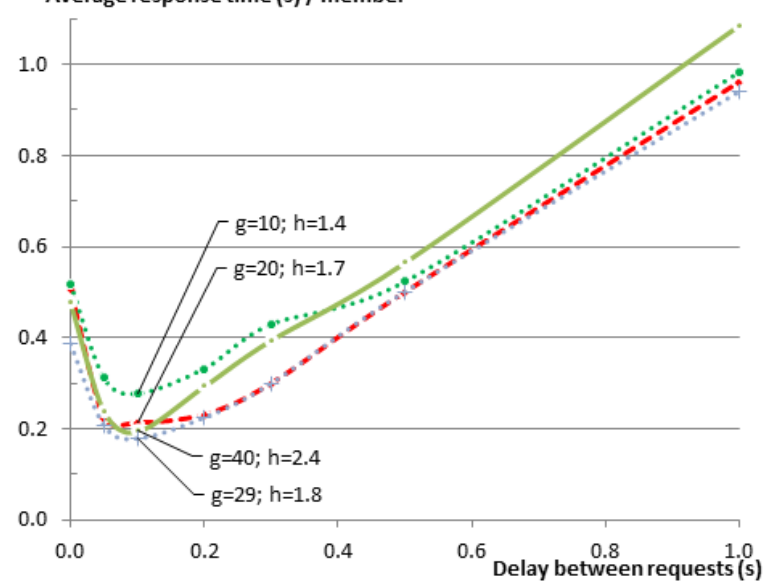
Figure 9. Entity response time per member for different group sizes as a function of the delay between individual requests to members, evaluated using the